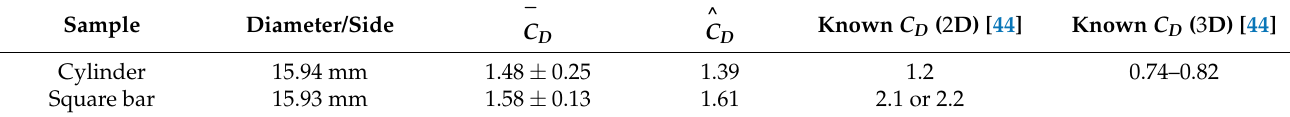
Table 8. List of the C D values obtained in our experiments compared to that presented in textbooks. The 2D and 3D refer to the two-dimensional and three-dimensional assumptions of the immersed bodies. The C D refers to the averaged coefficient of drag. The ˆ C D is obtained using the linear regression analysis of F D vs . V 2